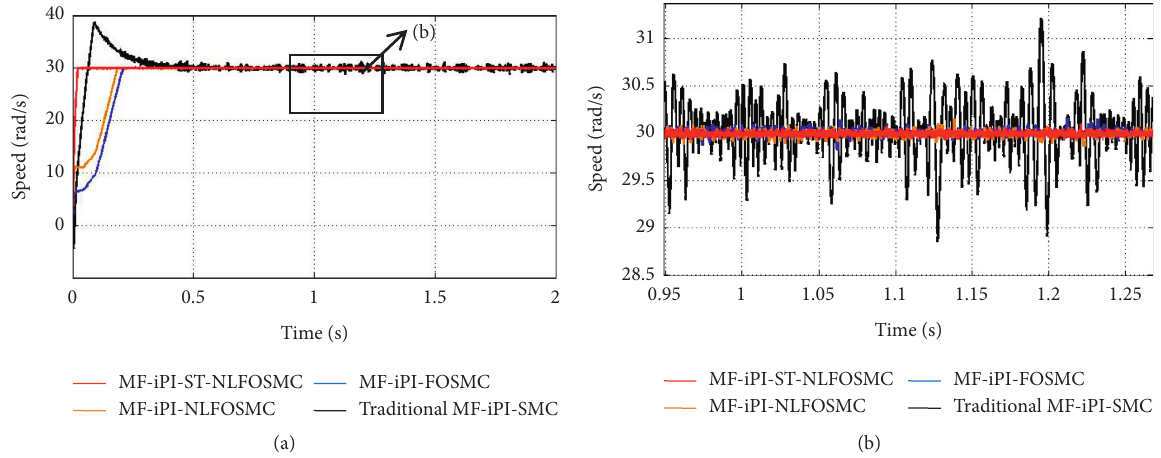
Figure 5: (a) Speed response curves under the traditional MF-iPI-SMC, the MF-iPI-FOSMC, the MF-iPI-NLFOSMC, and the MF-iPI-ST- NLFOSMC with load. (b) Magnification pictures of the speed response curves under the control strategies with load.